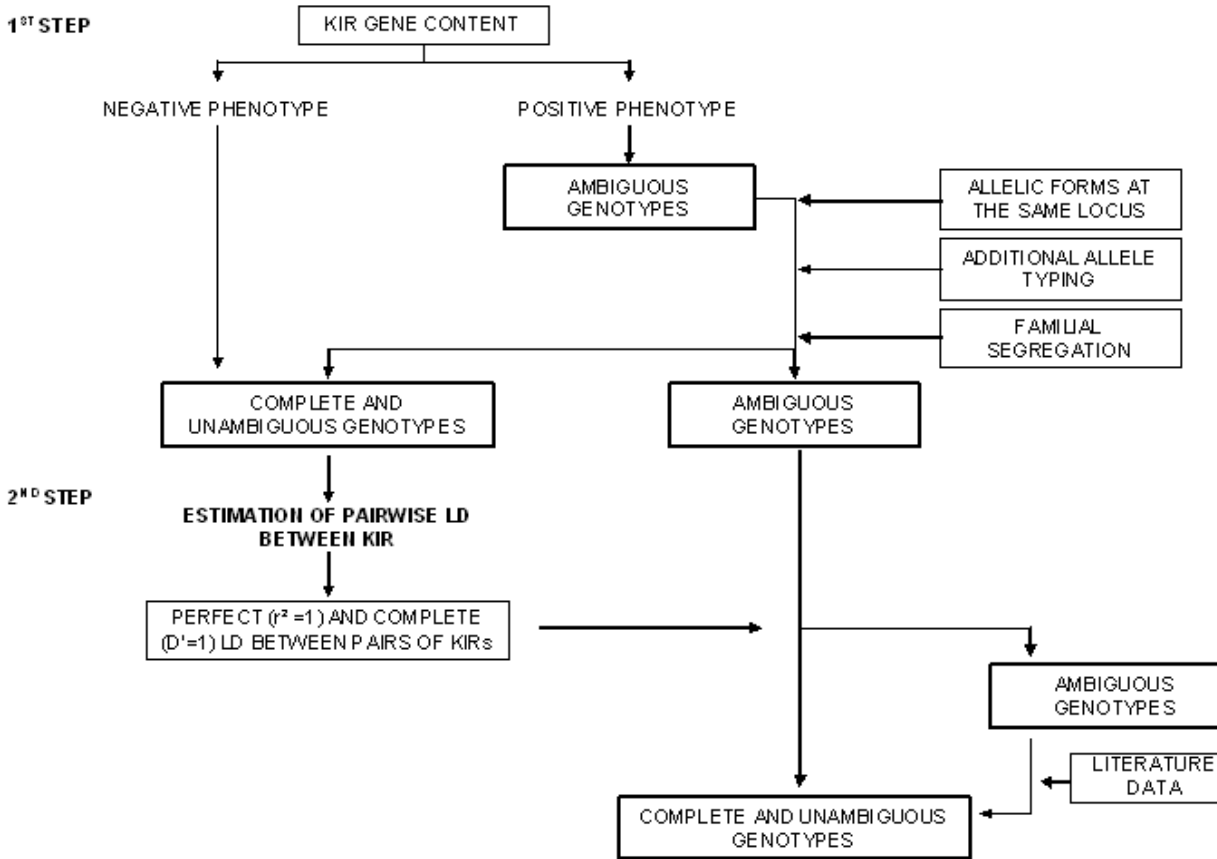
Figure 3. Genotypic reconstruction. KIR gene content analysis provides only binary phenotyping results for each KIR (absent or present), rather than complete genotypic information. Thus, for genotype analysis (i.e. the number of copies of each KIR gene), genotypic reconstruction in two successive steps was required. The first step combined the results of KIR gene content analysis, knowledge of allelic forms of KIRs , the additional allele typing carried out for three KIR genes, and the analysis of intra-familial segregation. KIR gene content made it possible to determine genotype unambiguously only in individuals with a negative phenotypic result. For example, an individual with a negative KIR2DS2 phenotype has no copy of the gene, and its genotype can be deduced and denoted KIR2DS2 ( 2 , 2 ). Conversely, an individual with a positive phenotype for KIR2DS2 may have either one copy of the gene, denoted KIR2DS2 ( + , 2 ), or two copies of the gene, denoted KIR2DS2 ( + , + ). Two of the nine variable KIR genes have known allelic forms: KIR2DL2/2DL3 and KIR3DS1/3DL1 . We defined as ( + , + ) the KIR3DS1/3DL1 genotype of subjects homozygous for the presence of KIR3DS1